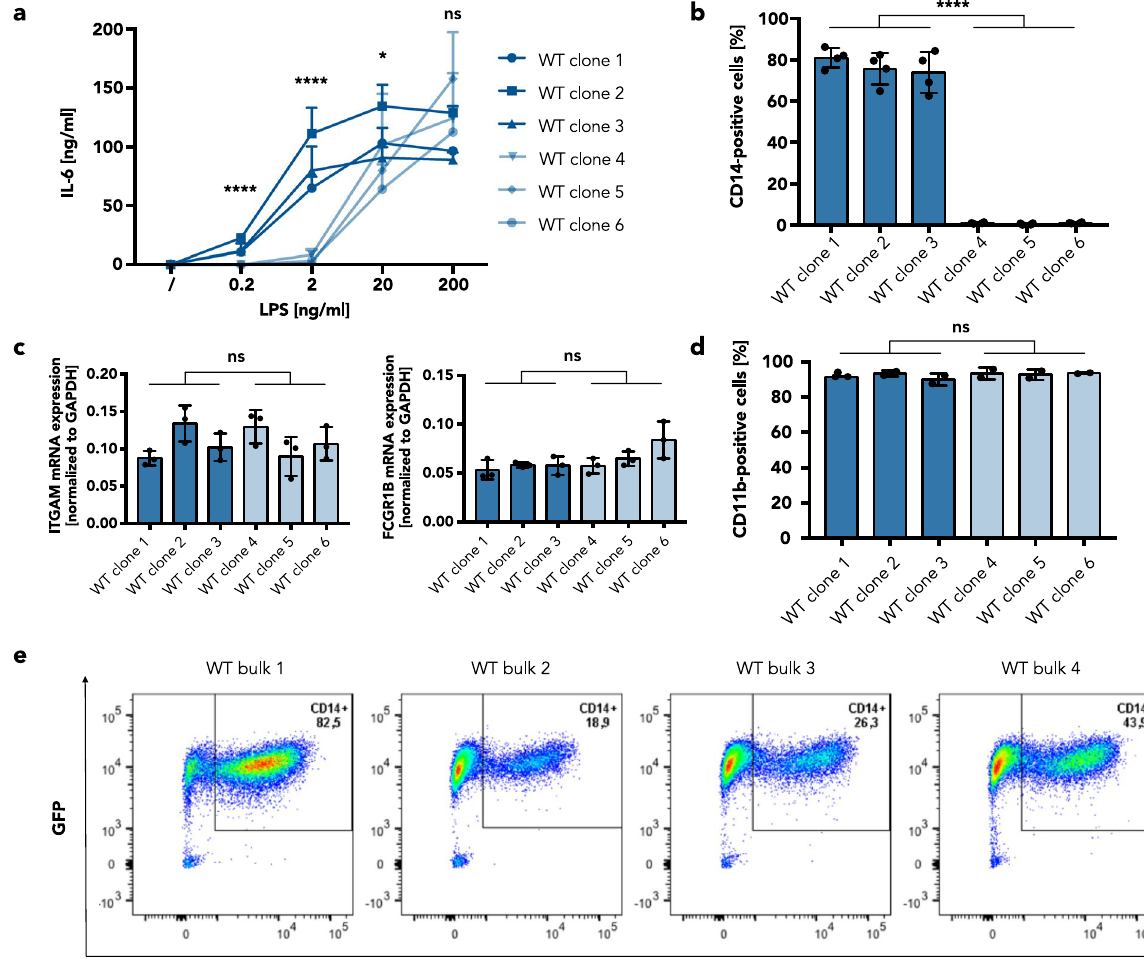
Figure 2. Reduced LPS responsiveness in BLaER1 monocytes is caused by a lack of CD14 surface expression. ( a ) After stimulation of transdifferentiated BLaER1 monoclonal cell lines for 16 h with LPS, IL-6 in the supernatant was measured by ELISA. Values correspond to the mean + SD of n = 3 independent experiments. ( b ) Percentage of cells expressing CD14 on the cell surface among all GFP-positive cells, assessed by FACS analysis of transdifferentiated BLaER1 clones. Shown is the mean ± SD of n = 4 independent measurements. Individual values are visualized as dots. ( c ) mRNA expression of the monocyte/macrophage markers ITGAM and FCGR1B in transdifferentiated WT clones, measured by qRT-PCR. Individual values are shown as dots. Columns correspond to the mean ± SD of n = 3 independent measurements, normalized to GAPDH expression. ( d ) Percentage of BLaER1 cells expressing CD11b on the cell surface among all GFP-positive cells after transdifferentiation for 5 days. Columns show the mean ± SD of n = 2 independent measurements. Dots represent the individual values. ( a–d ) Monoclonal cell lines with higher responsiveness to LPS (dark blue) were compared to cell lines with lower responsiveness to LPS (light blue) by Mann–Whitney test (ns—not significant, * p ≤ 0.05, **** p ≤ 0.0001). ( e ) FACS analysis of bulk CD14 surface expression in BLaER1 cells transdifferentiated for 5 days. The percentage of cells contained in the GFP+/CD14+ population is labeled in the upper right corner of each